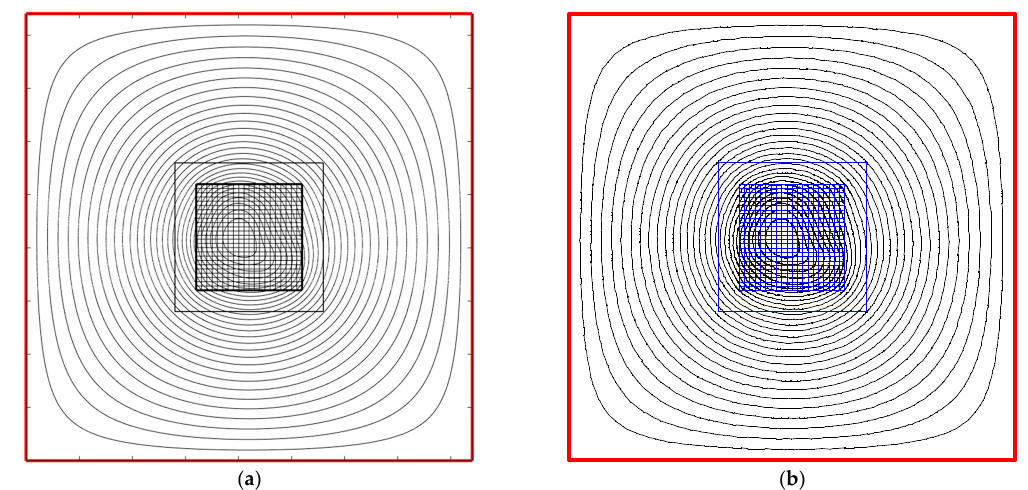
Figure 9. Equipotential lines of z A for a healthy FC obtained by ( a ) 2D multi-layer model and ( b ) 2D FEA.